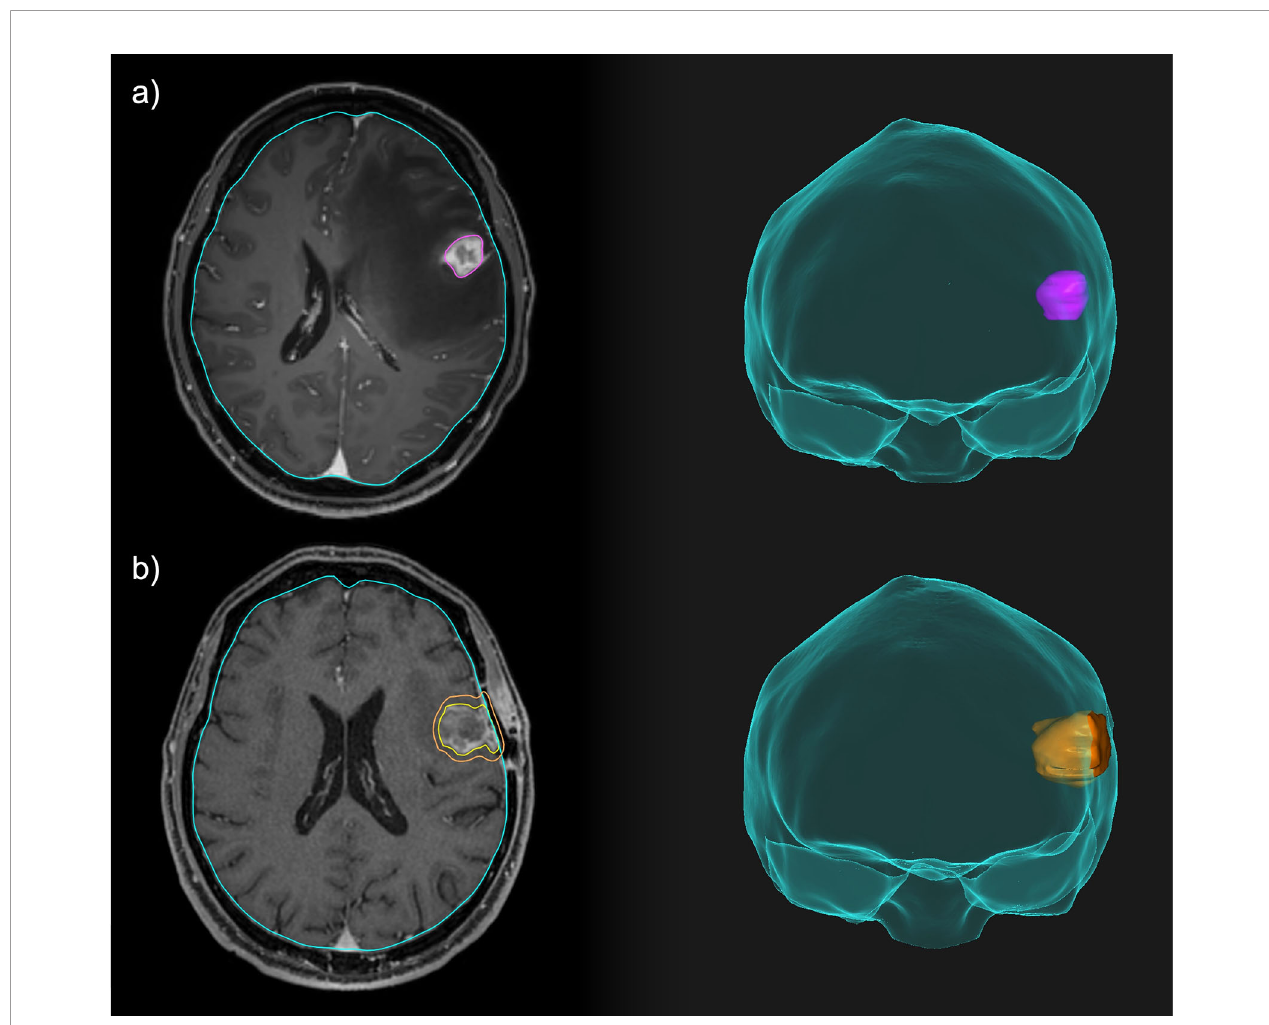
FIGURE 2 | Comparison between neoadjuvant and adjuvant focal RT for a resectable brain lesion. (A) Pre-operative treatment volume including only the macroscopic disease. (B) Post-operative treatment volume including the resection cavity, the surgical tract and a 3-mm expansion